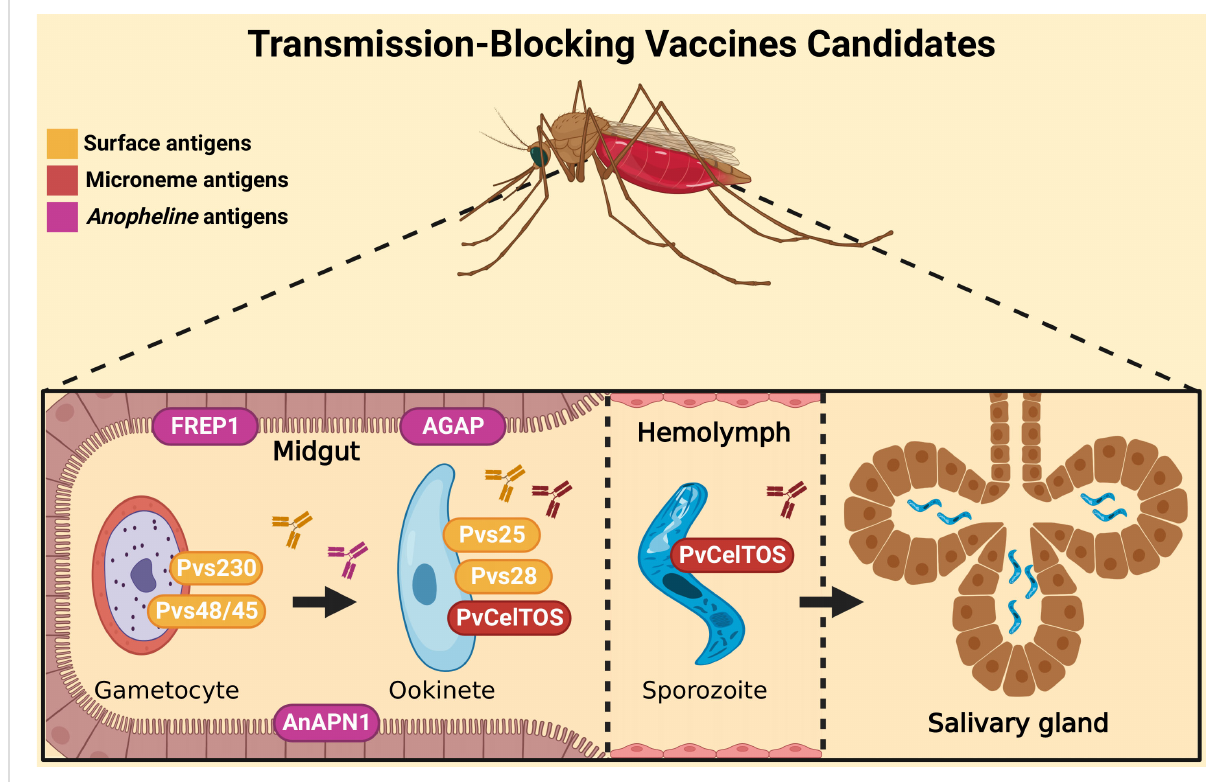
FIGURE 4 Transmission-blocking vaccine targets. TBV candidates are proteins expressed by sexual forms of the parasite. Pvs230 and Pvs48/45 are expressed on the gametocyte surface (yellow), while Pvs25 and Pvs28 (both surface antigens) and PvCelTOS (microneme antigen) are important for ookinete development. The PvCelTOS is also expressed on sporozoites microneme (red) during salivary-gland invasion. Other candidates are Anopheline antigens (purple), such as FREP1, AnAPN1 and AGAP, which have a role in sexual parasite form maturation. Antibodies against these proteins (represented by “ Y shaped ” on the fi gure) can interrupt the development of the following forms. Therefore, these vaccines are designed to block or reduce the transmission of the parasites. Created with